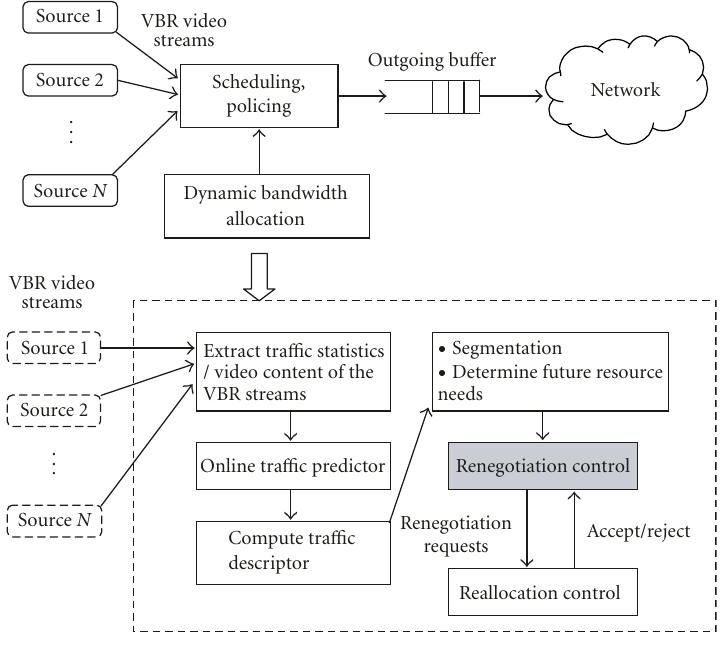
Figure 1: Dynamic bandwidth allocation